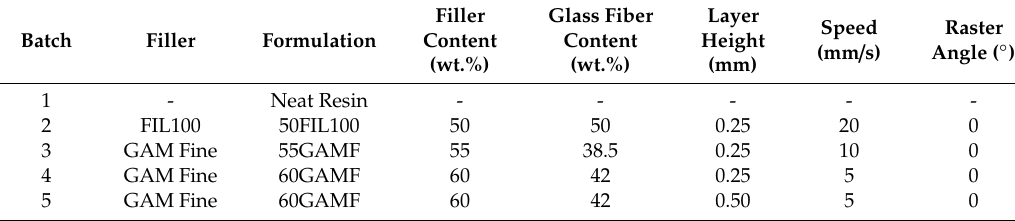
Table 2. 3D Printing parameters for the di ff erent tensile specimen